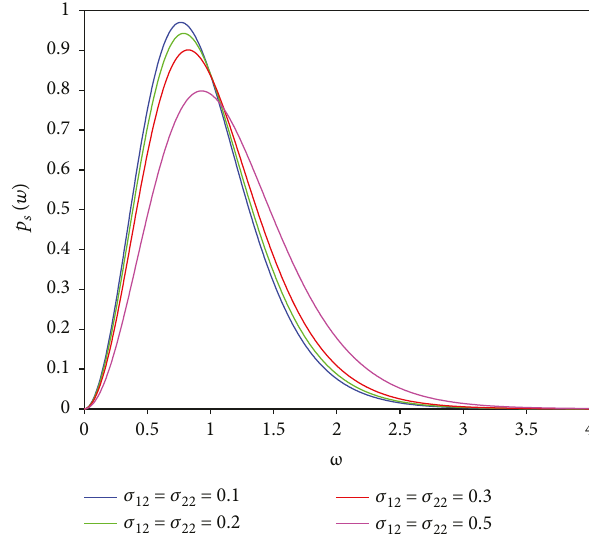
Figure 3: Parameter values for numerical simulations are given as follows: r 1 = 2 , b 1 = 0 4 , a 1 = 0 5 , k = 6 , q = 0 1 , m 1 = 1 , m 2 = 2 , r 2 = 0 3 , a 2 = 2 , w = 5 , c = 1 , and v = 0 5 . When γ u = 0 i = 1, 2 i ω and occurrence and τ 1 = τ 2 = 0 , the probability densities p s positions of stochastic Hopf bifurcation of system (27) with σ 11 = 0 1 and σ = 0 5 and di ff erent values of σ σ 21 12 and 22 , where (a) = σ = 0 1 , (b) σ = σ = 0 2 , (c) σ = σ = 0 3 , and (d) σ 12 22 12 22 12 22 σ = σ = 0 5 12 22